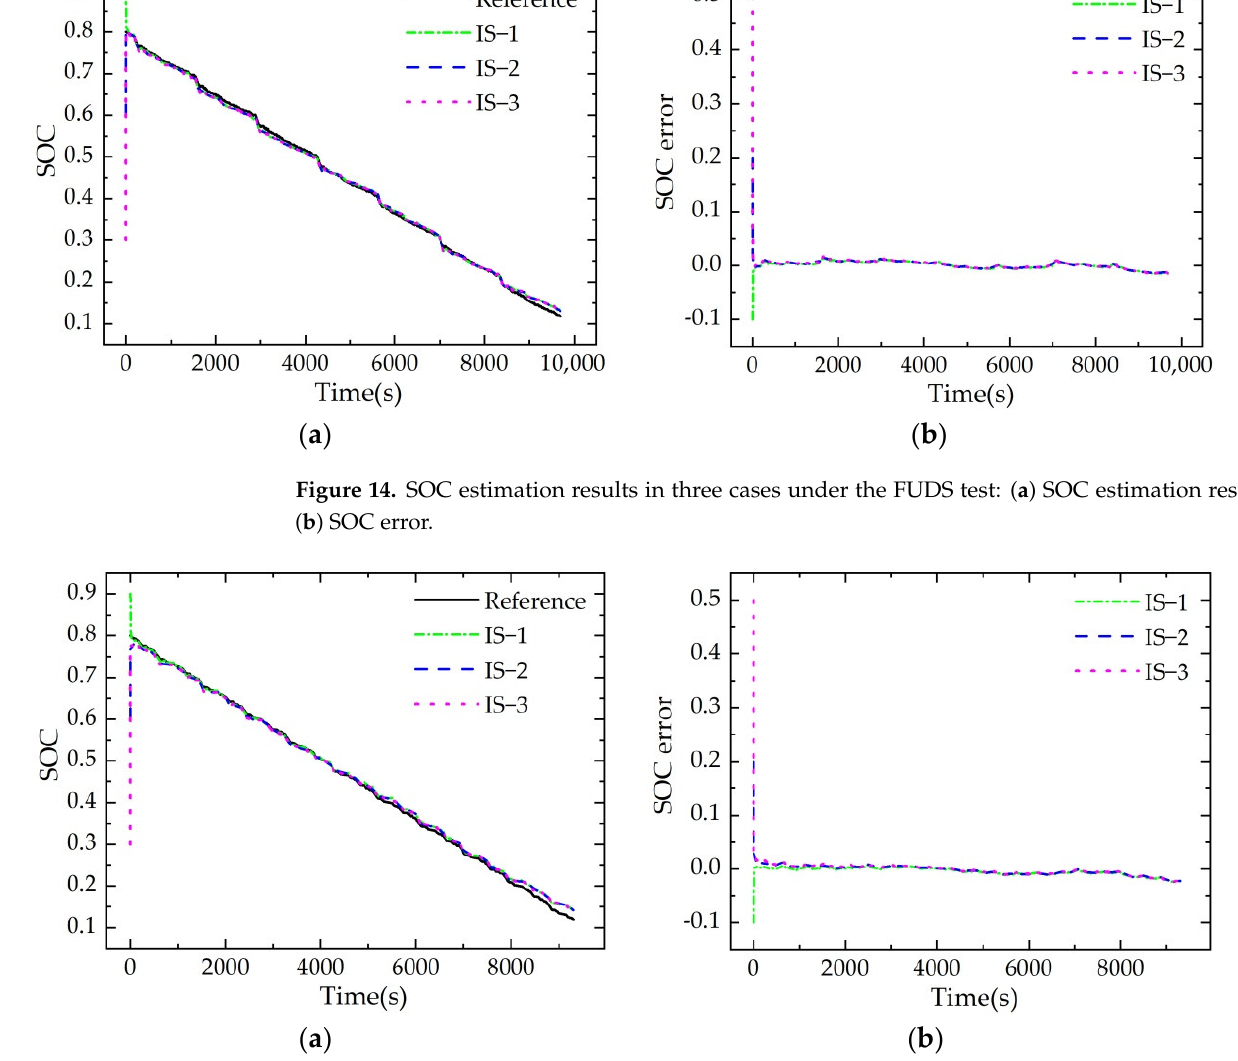
( b ) Figure 16. SOC estimation results in three cases under the US06 test: ( a ) the estimated SOC; ( b ) the SOC error. Table 9. SOC error (%) in cases IS–1, IS–2 and IS–3 under different tests. Case